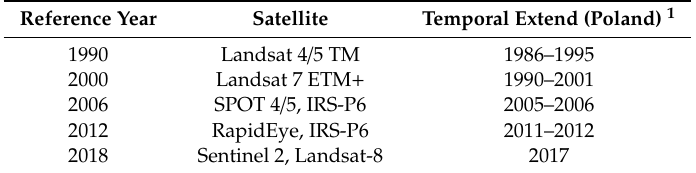
Table 2. Overview of satellite data used for land cover interpretation in Poland.